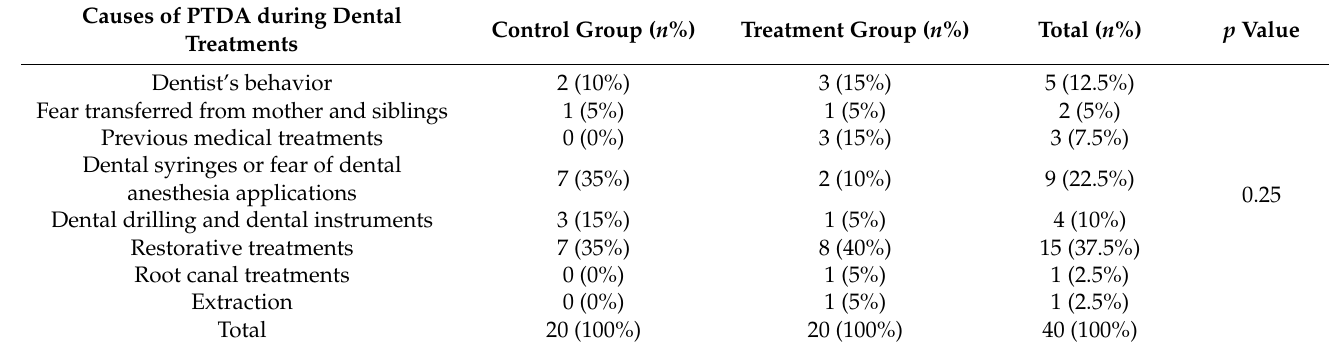
Table 3. Frequency of PTDA causes during dental